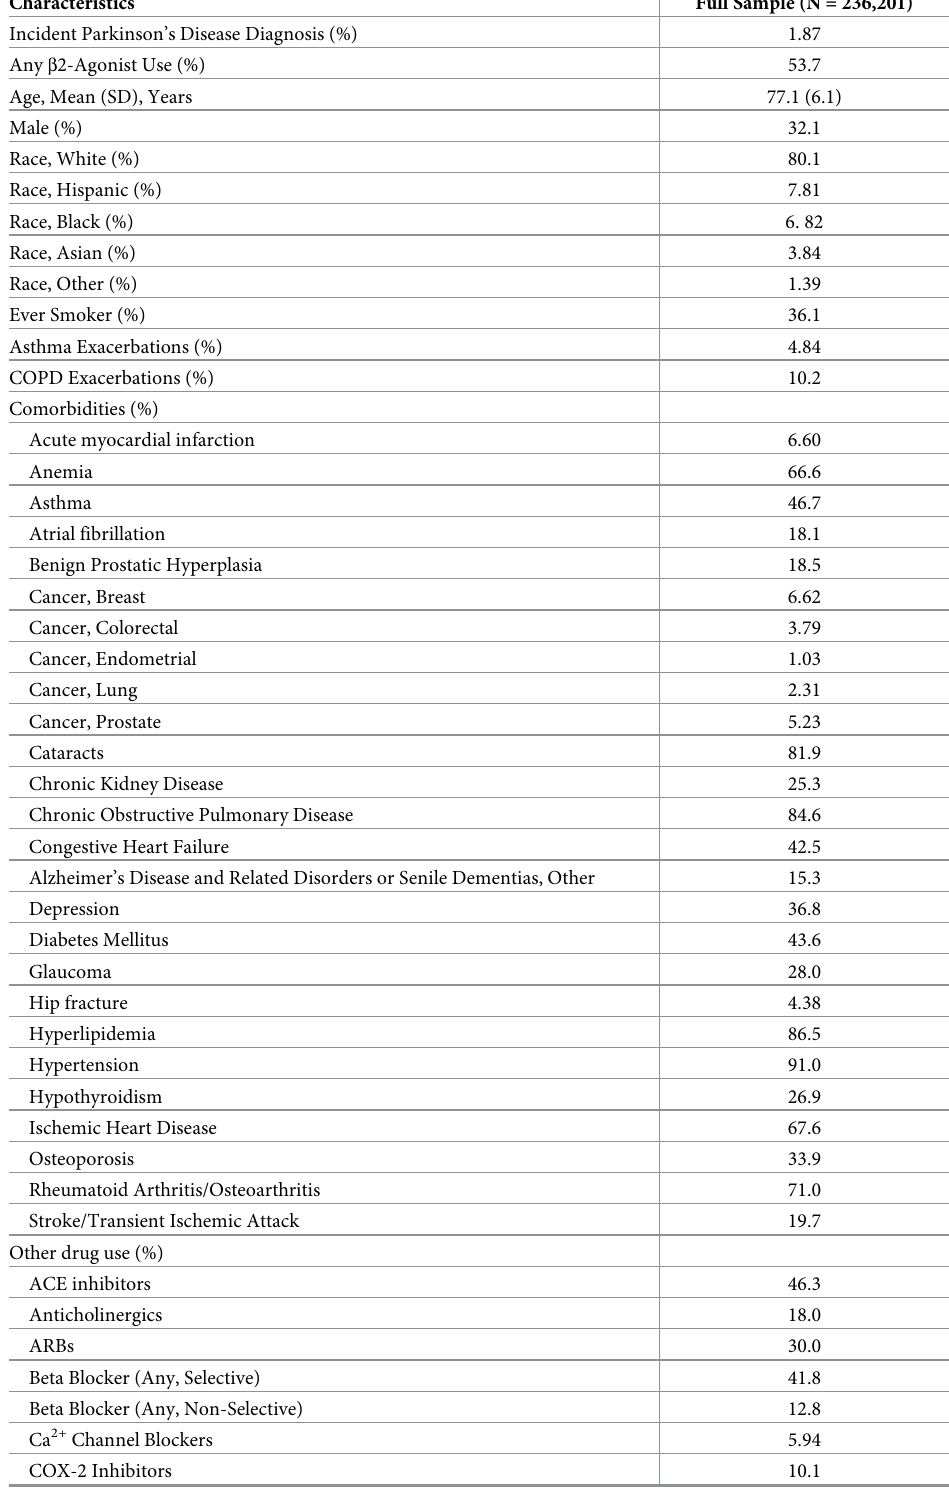
Table 1. Descriptive statistics of study